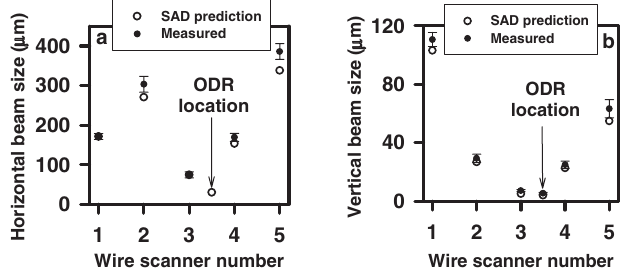
FIG. 13. Horizontal (a) and vertical (b) beam sizes measured with five wire scanners in the extraction line (black circles) and predicted with SAD code (open circles). The point between third and fourth wire scanners corresponds to the ODR target location. The vertical beam size was measured with 10 (cid:8) m tungsten wire.